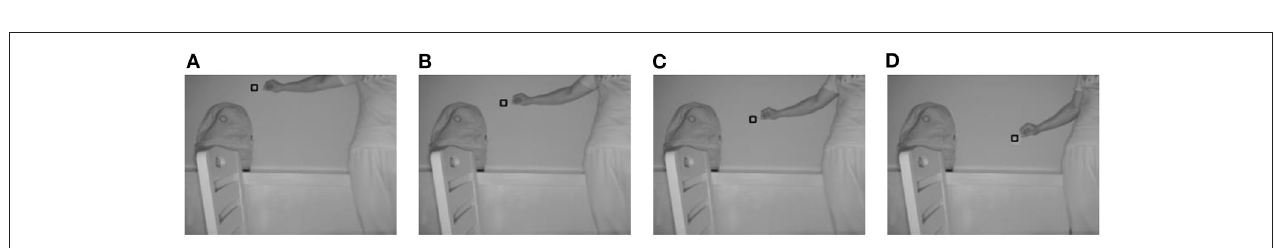
FIGURE 4 | Tracking results from the method of thresholding the density distribution of the dataset into which depth information is introduced. (A) The 10th frame; (B) the 30th frame; (C) the 50th frame; (D) the 80th frame.